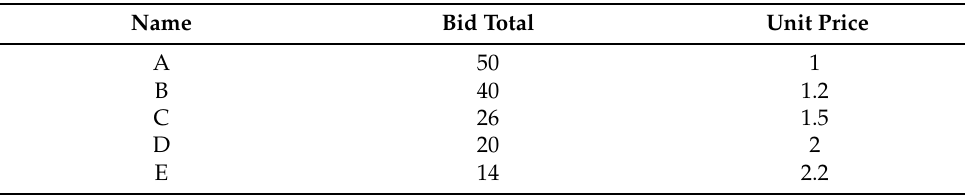
Table 1. Data for